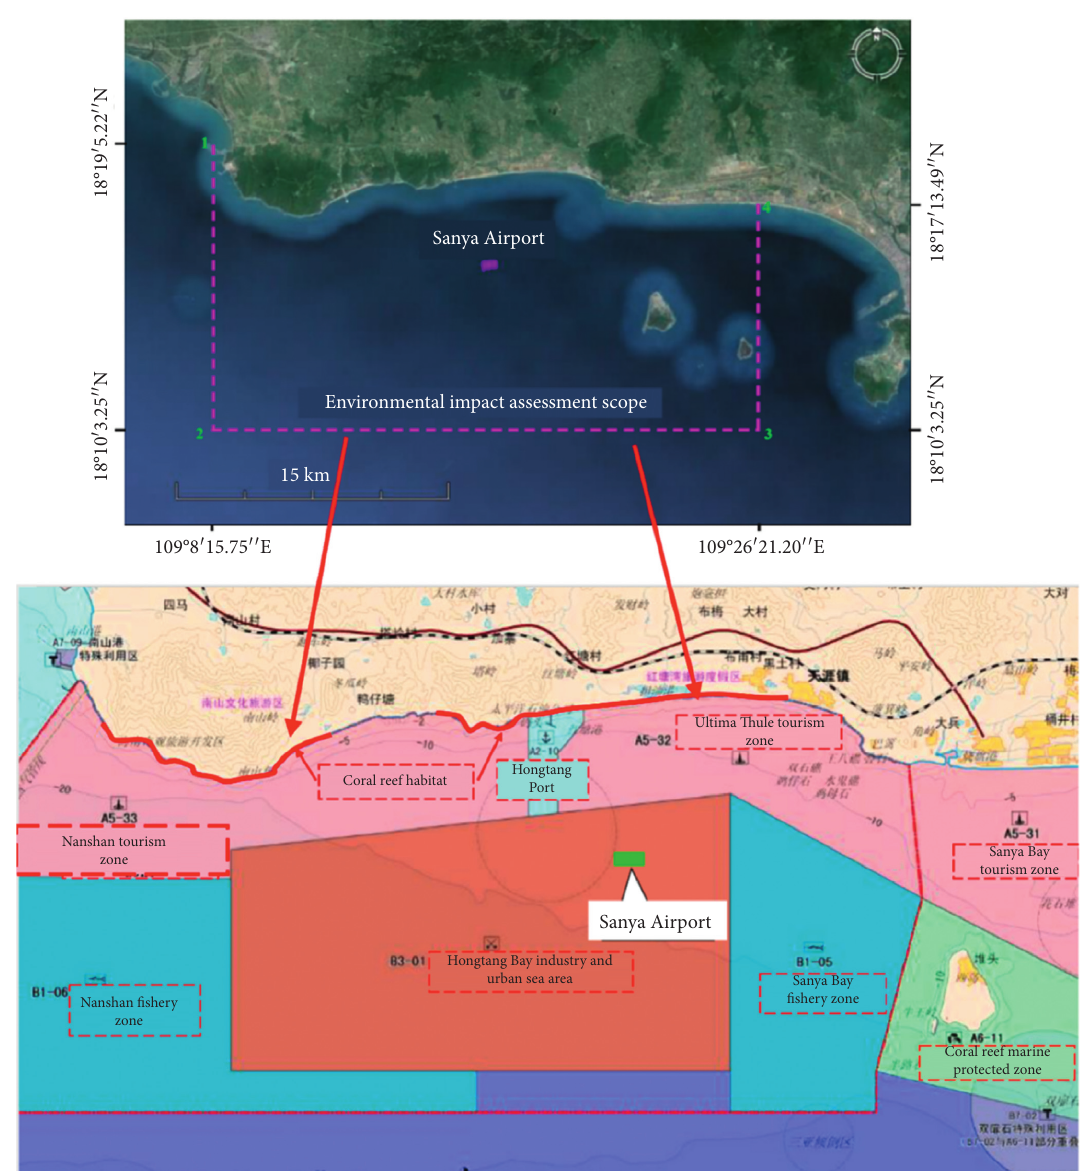
Figure 3: Environmental impact assessment scope of SSRA.